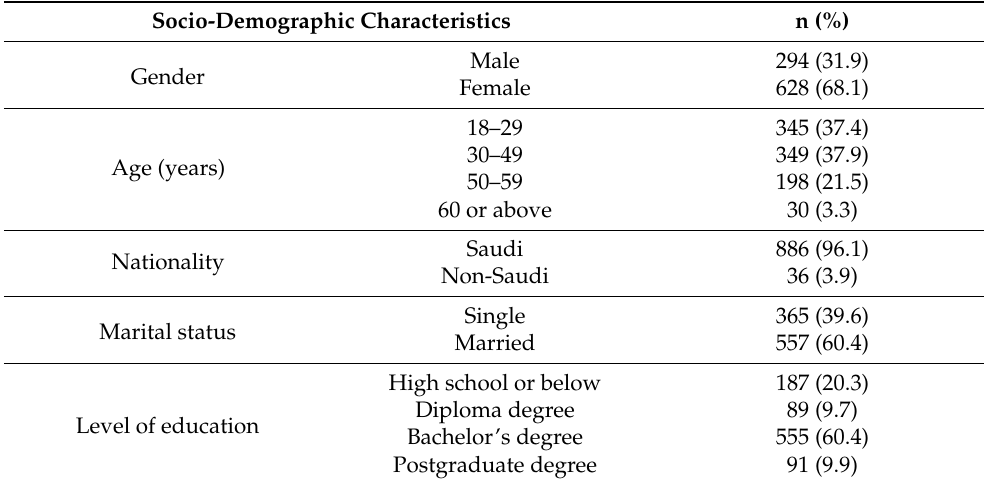
Table 1. Socio-demographic characteristics of the study participants (n =